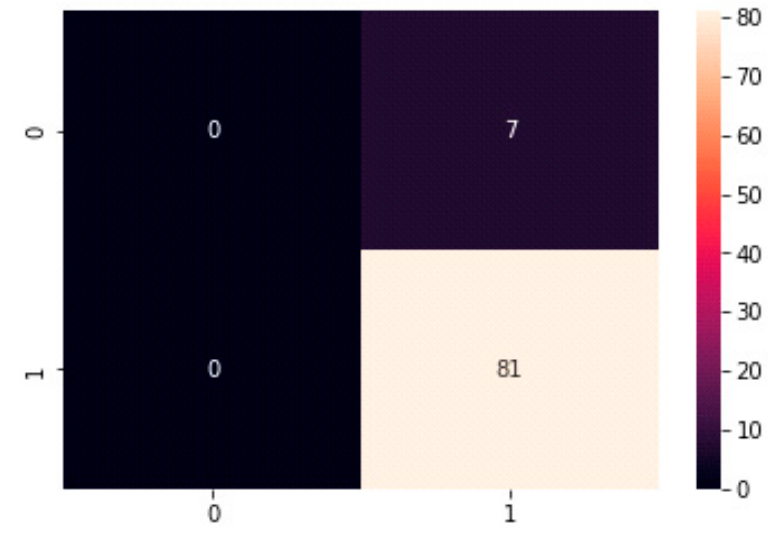
Figure 13. Confusion matrix of the proposed model of test data.